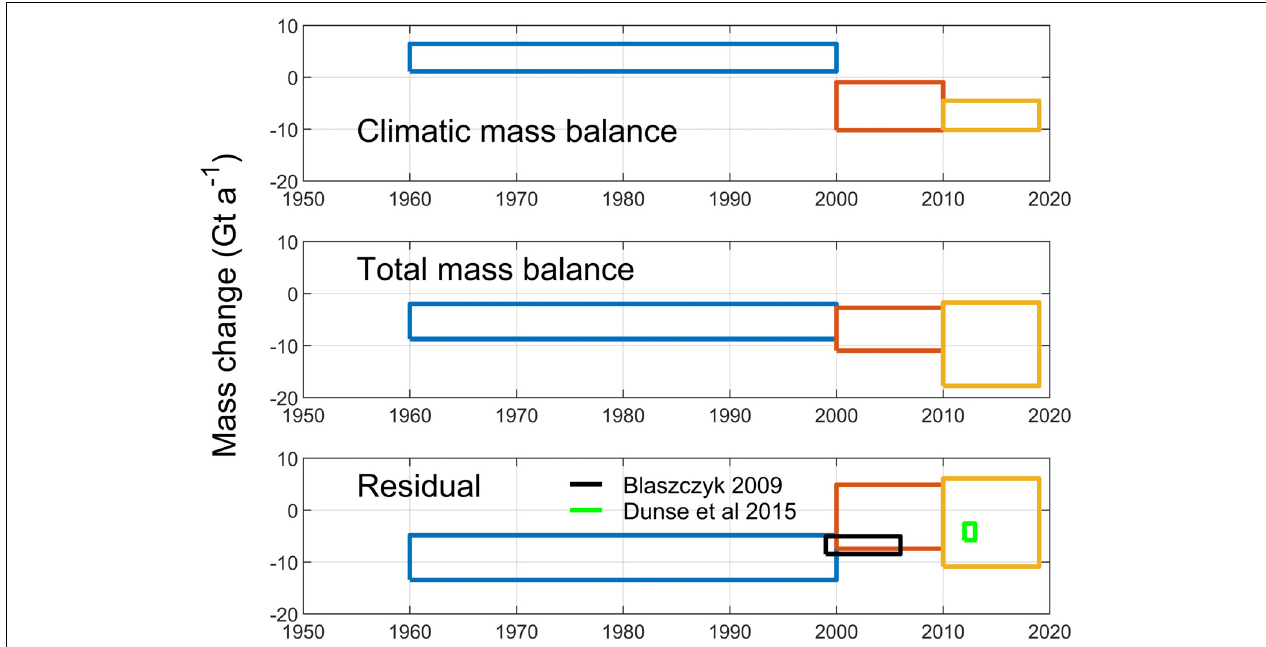
FIGURE 4 | Reconciled estimates for climatic mass balance, total mass balance and residuals for the three epochs. The residual comprises frontal ablation and the related uncertainty. The estimates are represented by colored boxes, their width representing the period for which the estimate has been derived and the height representing the uncertainty of the mass